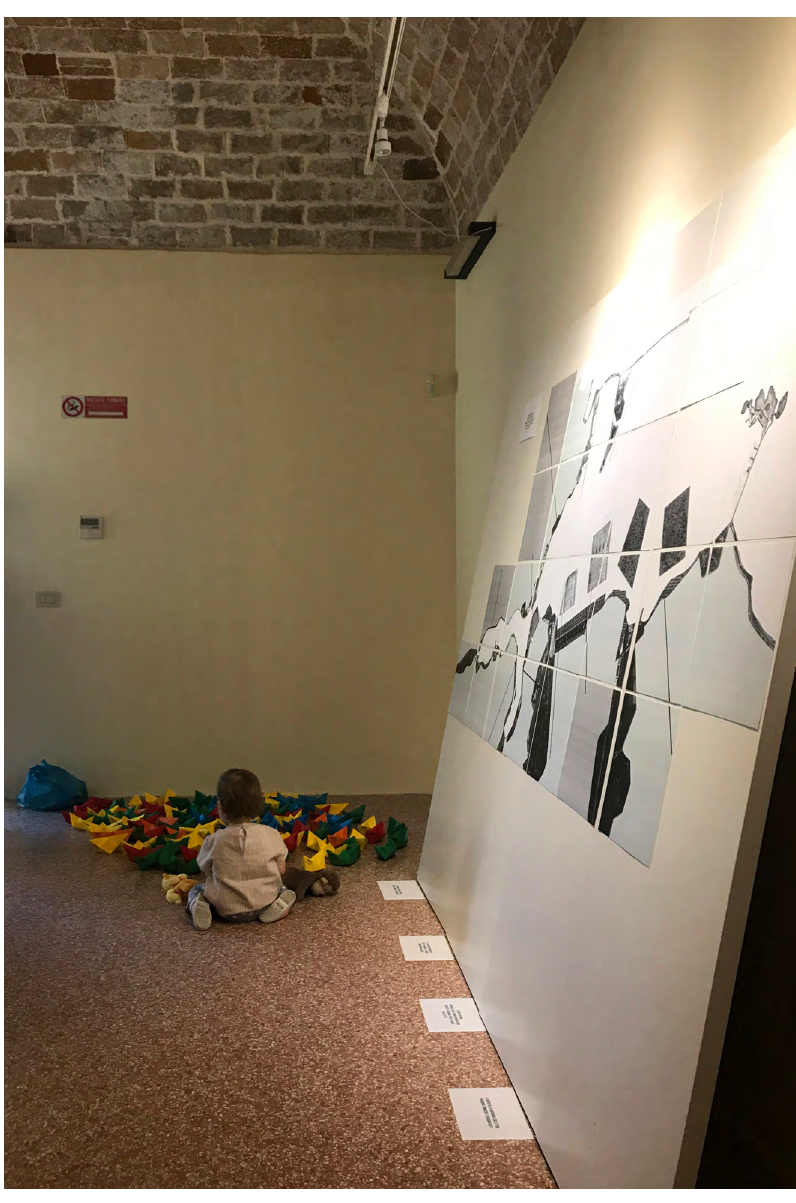
View of the public exhibition in Palazzo Nervegna of Brindisi, photo by Amina